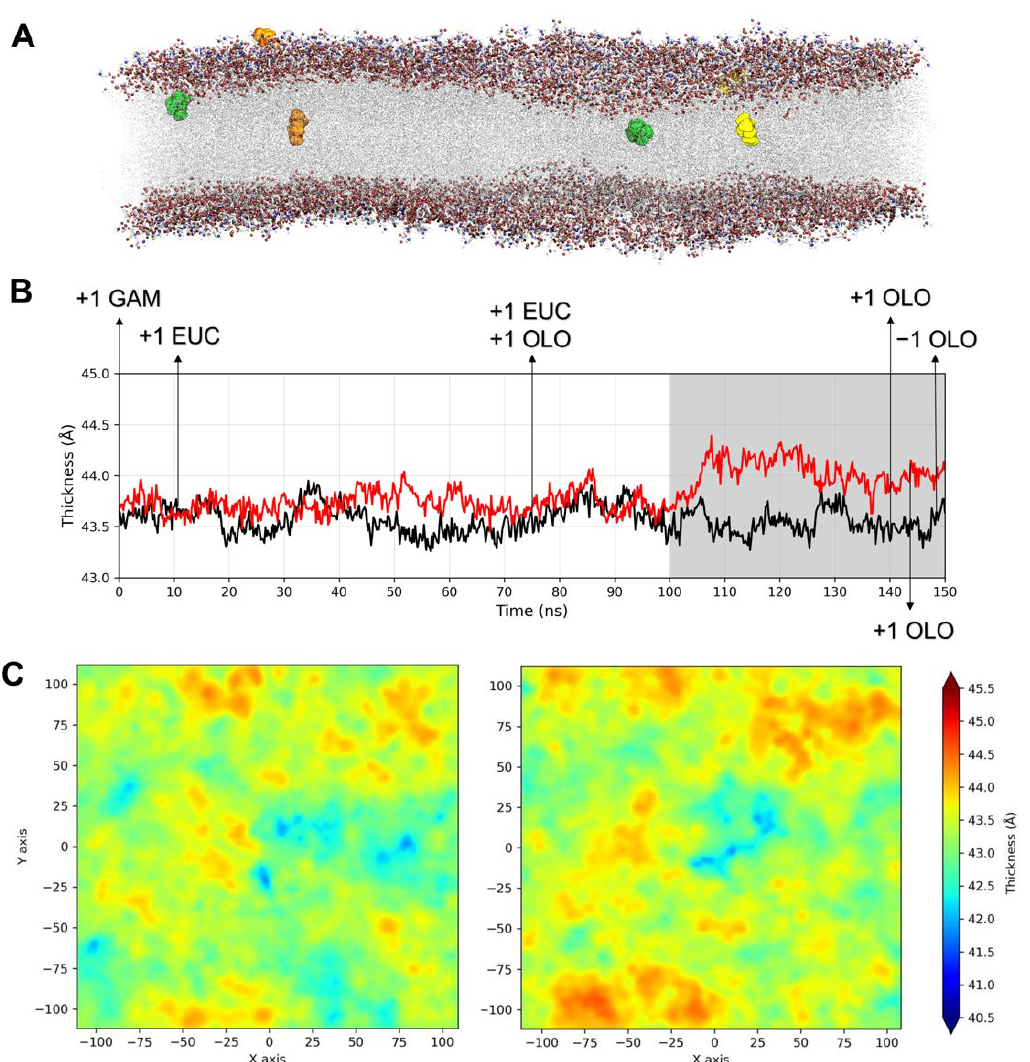
Figure 2. ( A ) Binding locations observed for the γ -terpinene (orange), terpinen-4-ol (yellow), and 1,8-cineole (green) molecules, shown as spheres, within the viral membrane bilayer; ( B ) membrane thickness as a function of the simulation time in the absence (black line) or presence (red line) of the TTO compounds. Arrows indicate the time-points at which the entry (+1) or exit ( − 1) of the molecules was observed, and the grey background highlights the thickness shift; ( C ) thickness heatmaps for the viral membrane in the absence (left) or presence (right) of the TTO molecules.